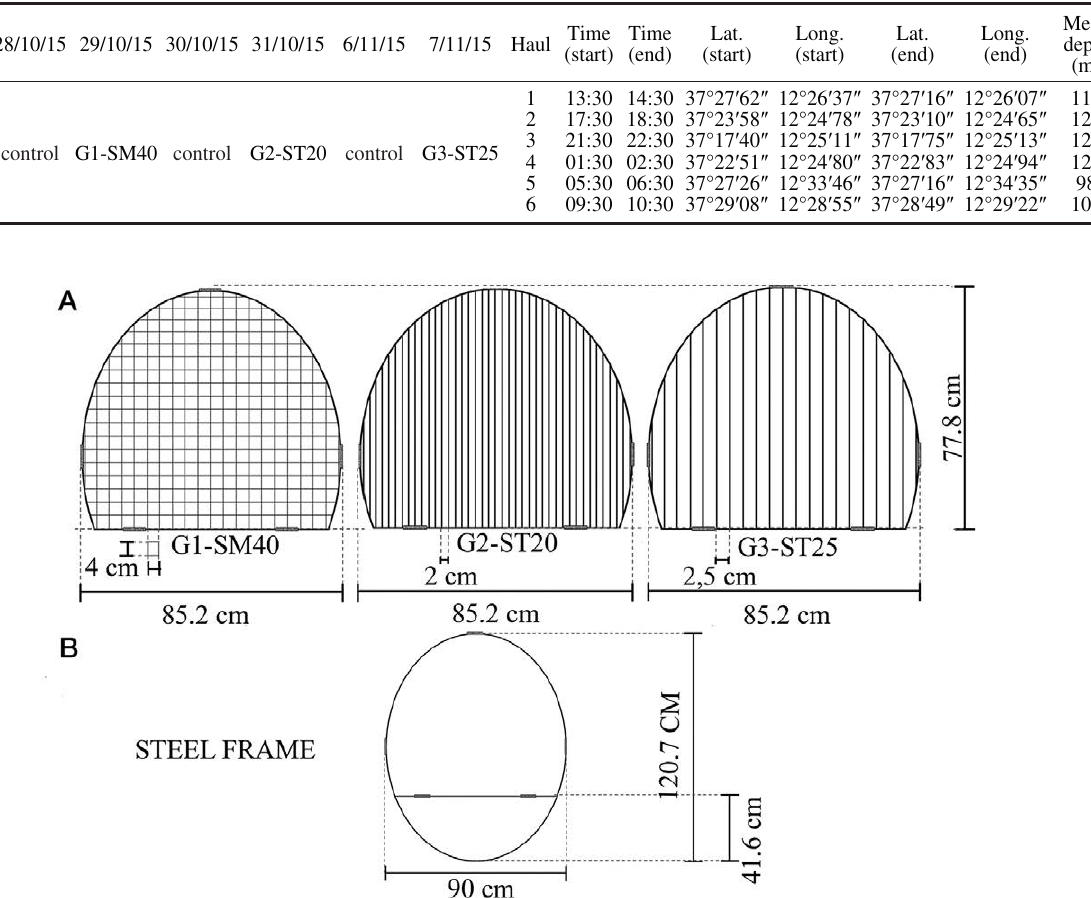
Table 1. – Days, number of repeated hauls, geographic coordinate and mean depth for each designed JTED and its relative control in the experimental survey. G1-SM40, JTED covered with a net of 40-mm square mesh; G2-ST20, JTED with steel bars spaced 20 mm; G3-ST25, JTED with steel bars spaced 25 mm.